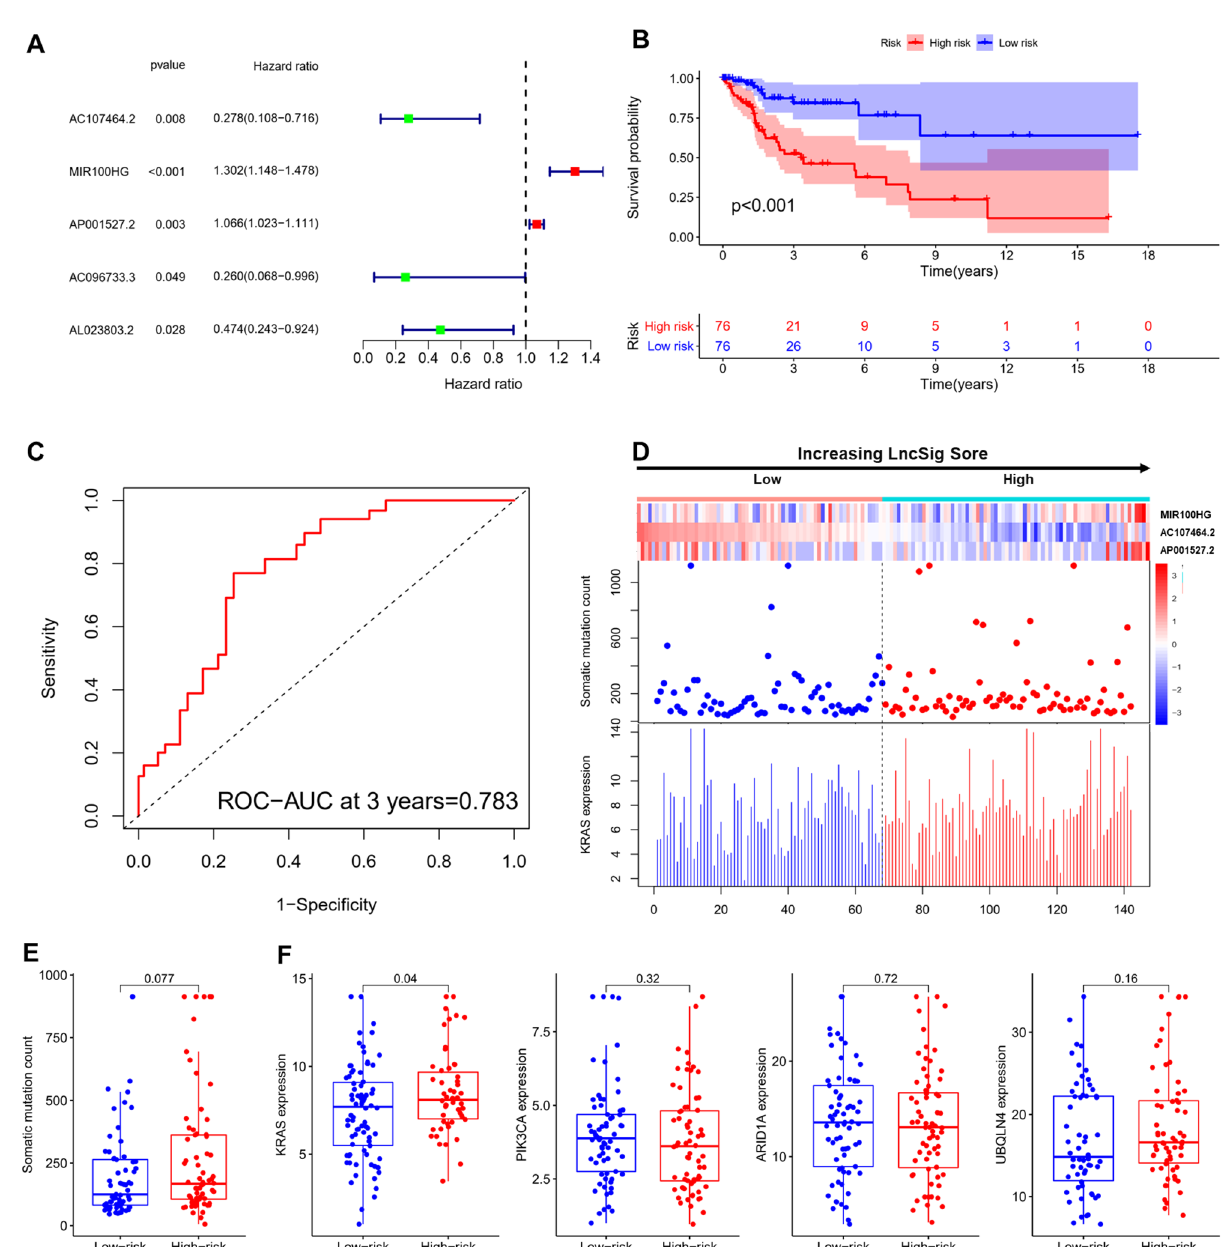
Figure 3. Establishment of the prognostic model and validation of the genomic instability-derived lncRNA signature (LncSig) for outcome prediction in the training set. ( A ) 5 lncRNAs for establishment of the prognostic model. ( B ) Estimates of overall survival of patients with low or high risk predicted by the LncSig in the training set ( p < 0.001). ( C ) Time-dependent ROC curves analysis of the LncSig at 3 years (AUC = 0.783). (D) With increasing LncSig score, LncRNA expression patterns, the distribution of somatic mutation and KRAS expression. ( E ) The distribution of somatic cumulative mutations in high- and low-risk groups. ( F ) KRAS, PIK3CA, ARID1A and UBQLN4 expression in the high- and low-risk groups. The red represents the high-risk group, and the blue represents the low-risk